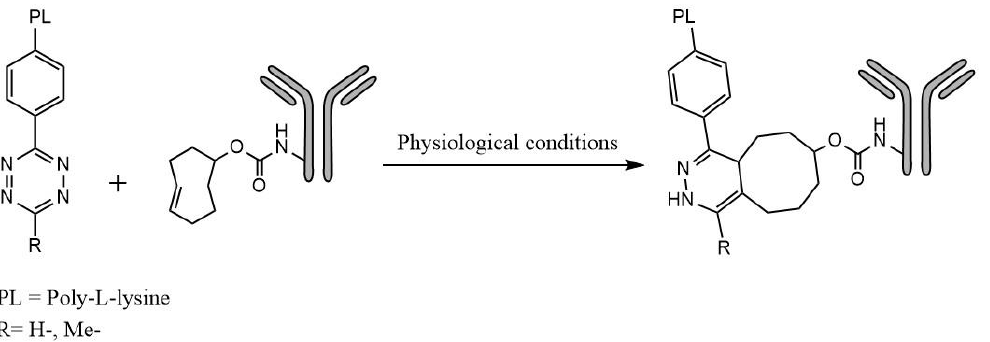
Figure 1. Inverse electron demand Diels–Alder (IEDDA) reaction between tetrazine (Tz)-modified poly-L-lysine (Tz-PL) effector molecule and trans-cyclooctene (TCO)-modified monoclonal antibody (TCO-mAb) pretargeting agent.